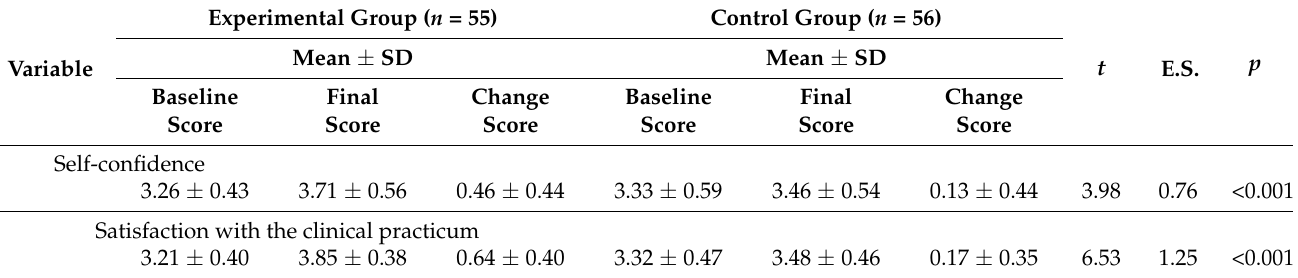
Table 2. Effects of self-directed clinical practicum ( n =